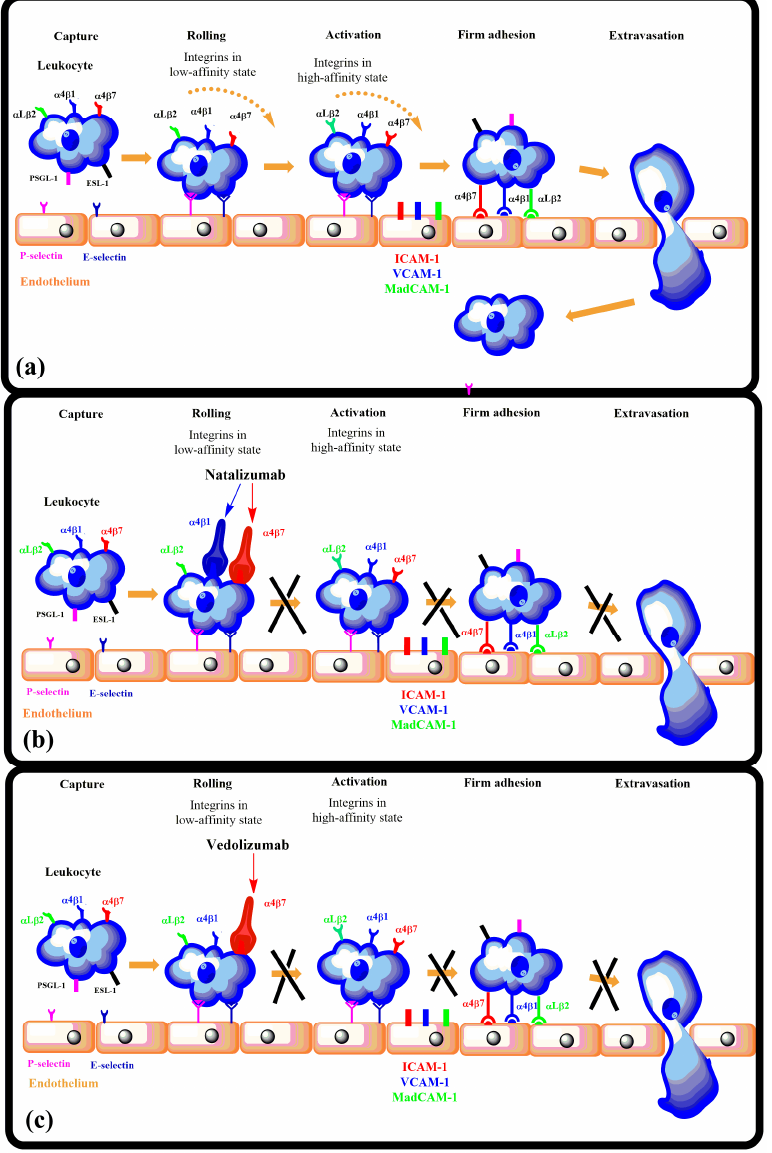
Figure 10. The therapeutic action of natalizumab and vedolizumab. Integrin antagonists inhibit leukocyte migration into endothelium: ( a ) leukocyte adhesion cascade, ( b ) natalizumab binds to both the α 4 β 1 and α 4 β 7 integrins, thus blocking leukocyte adhesion, ( c ) vedolizumab binds only to the α 4 β 7 integrin, which minimizes potential side effects. Based on ref.